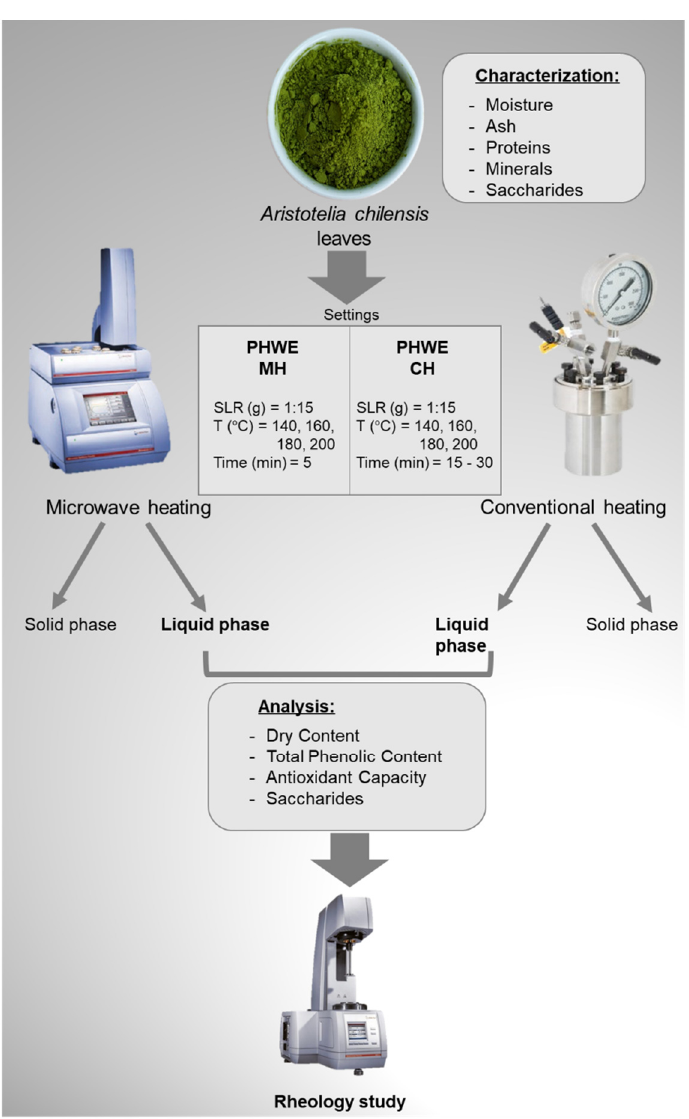
Figure 7. Scheme of the experimental and analytical approaches during the study of pressurized hot water extraction with microwave heating (PHWE-MH) and conventional heating (PHWE-CH) of bioactive compounds from Aristotelia chilensis